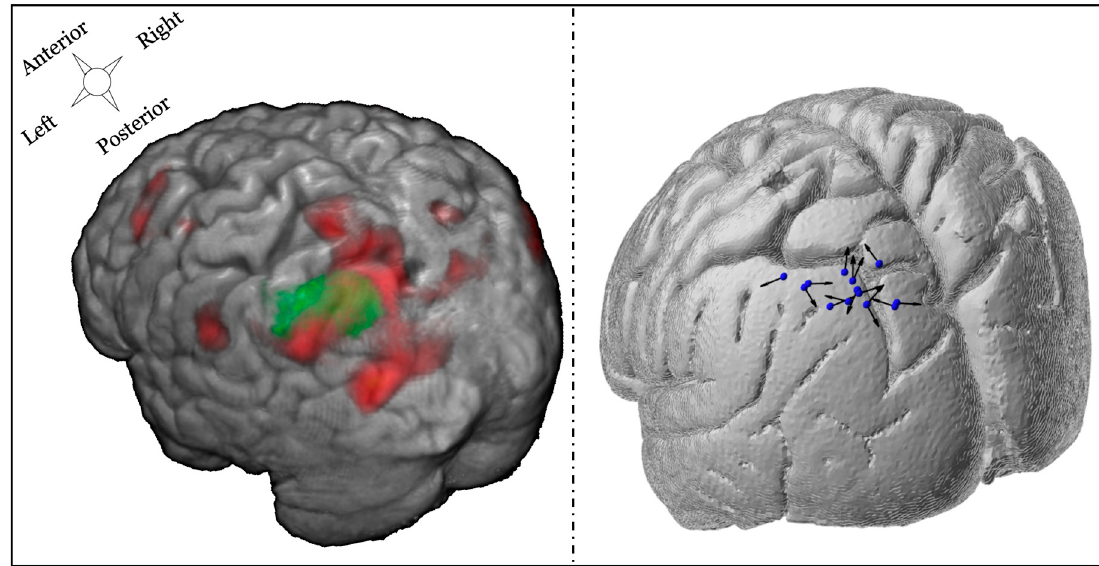
Figure 5. Illustration of fMRI targeting and final TMS positioning. Left panel: example of one individual subject combining the group mask over the left parietal cortex (green) combined with individual fMRI activation (red) associated with the parametric increase in difficulty during the delay. Right panel: TMS coil position and orientation for each participant. The blue spheres represent the coil location, and the black arrows correspond to the direction of the second phase of the induced E-field pulse (some of the arrowheads are not visible because of the 3D view).